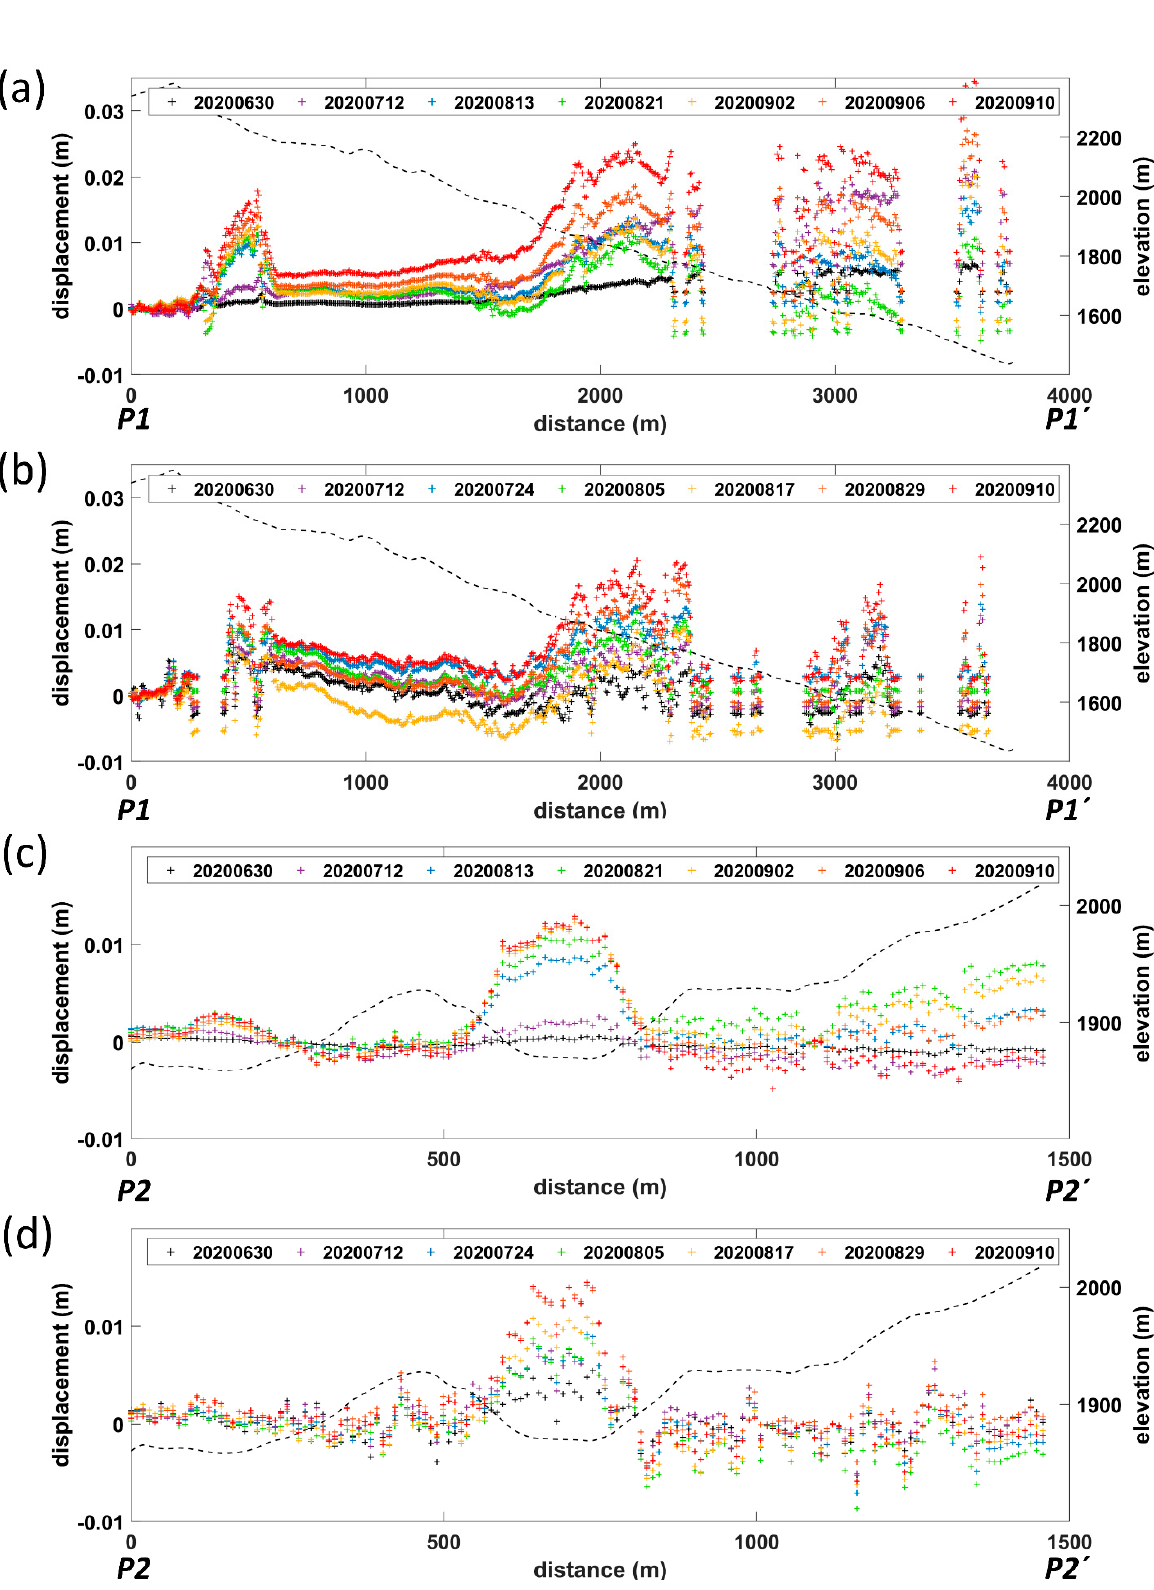
Figure 8. LOS time-series analysis of Site 5 displacement profiles. ( a ) RCM P1-P1 (cid:48) profile, ( b ) Sentinel-1 P1-P1 (cid:48) profile, ( c ) RCM P2-P2 (cid:48) profile, ( d ) Sentinel-1 P2-P2 (cid:48) profile. The black dashed lines represent elevations along the